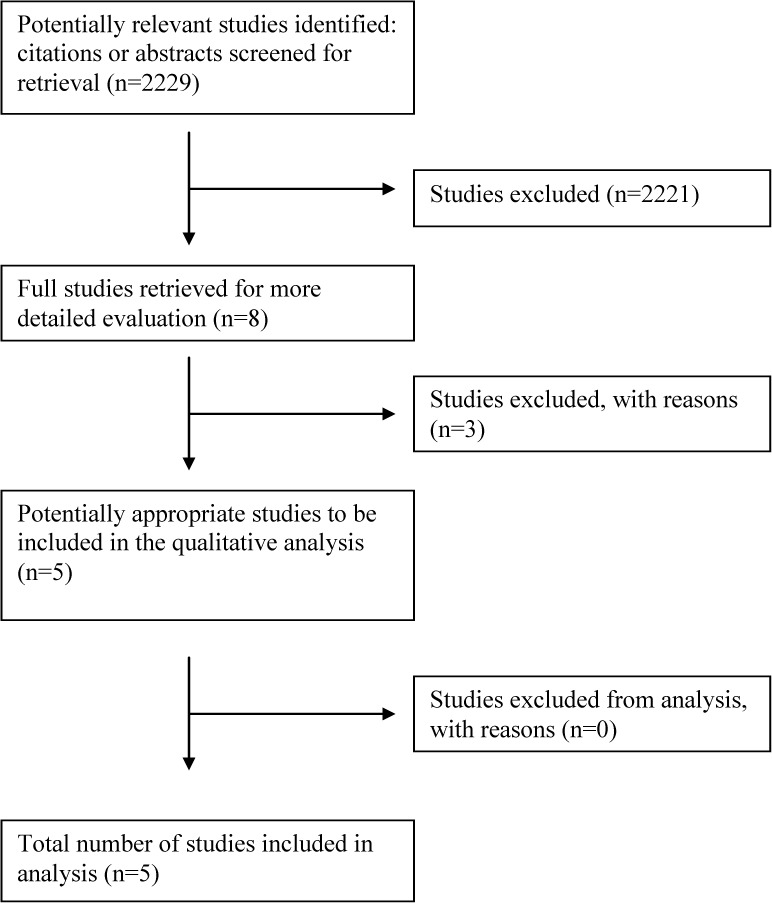
Flowchart diagram for the selection of studies.